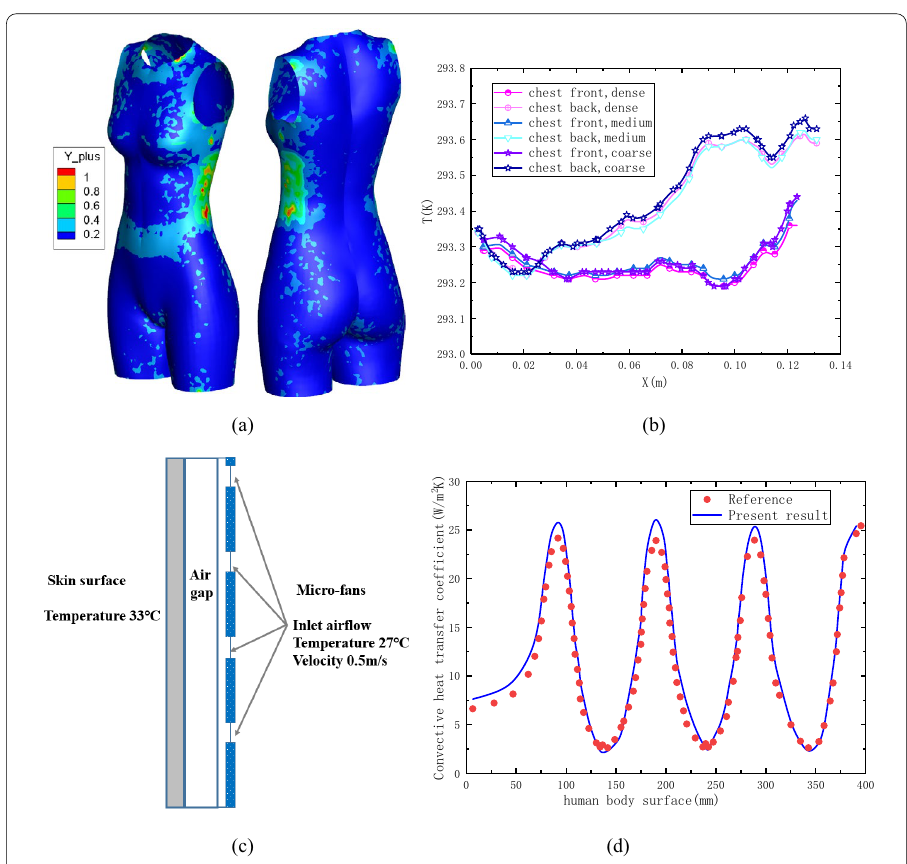
on body surface, b grid +